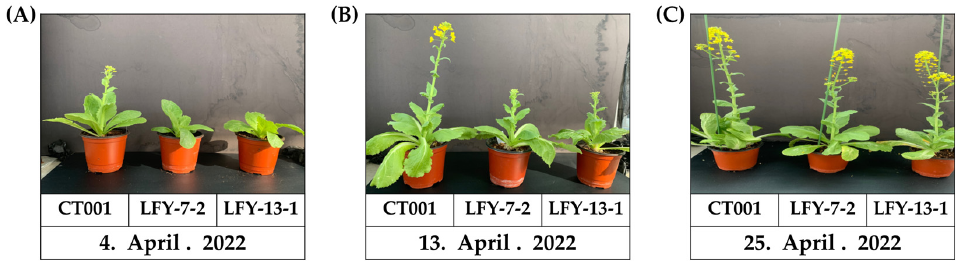
Figure 7. Confirmation of bolting time and normal growth of ‘CT001’ and E 1 T-DNA-free LFY -edited lines. ( A ) Early stage of bolting. Bolting of the inbred line ‘CT001’ (left); ( B ) Middle stage of bolting. Bolting of the E 1 T-DNA-free LFY -edited lines (middle and right); ( C ) End stage of bolting. Left, inbred line ‘CT001’; Middle and right, E 1 T-DNA-free LFY -edited lines. All lines showed normal growth.